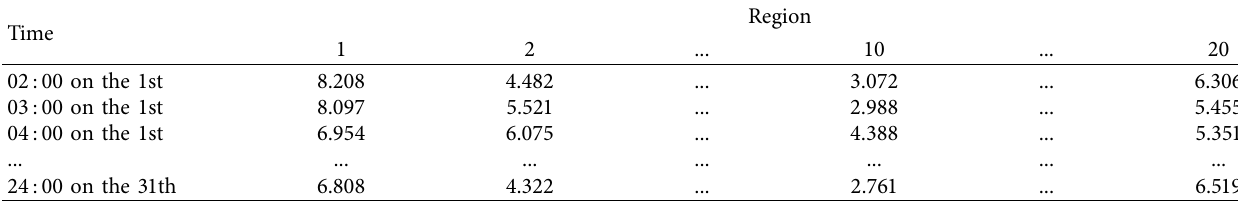
Table 3: Wind speed value of secondary fusion(m/s).